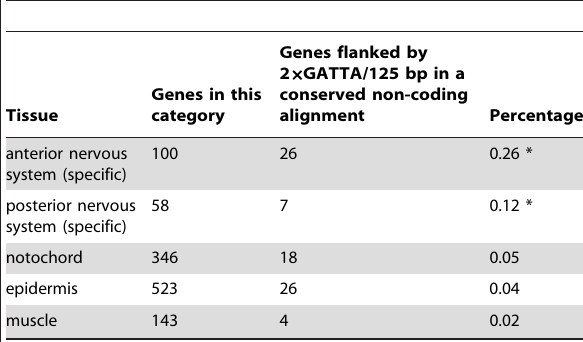
Table 1. Antero-posterior distribution of enhancers with 2 6 GATTA